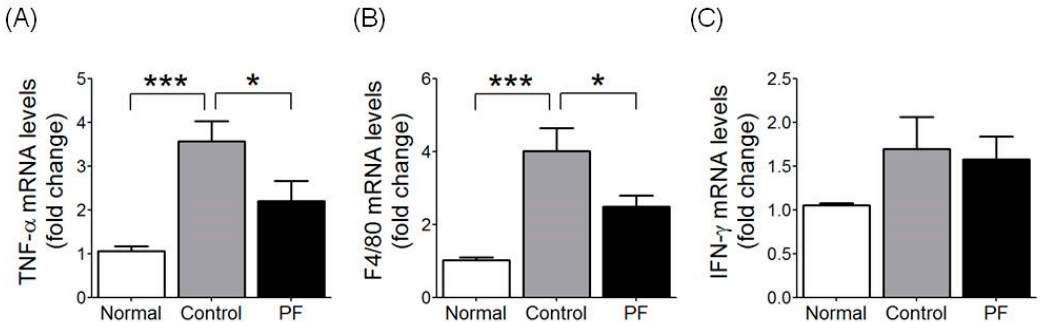
Figure 5. Effect of PF on inflammatory cytokine gene expression in liver. ( A ) TNF- α , ( B ) F4/80 and ( C ) IFN- γ . n = 6 in each group. Data shown are the mean ± SEM. * p < 0.05, *** p < 0.001, compared with HFD.